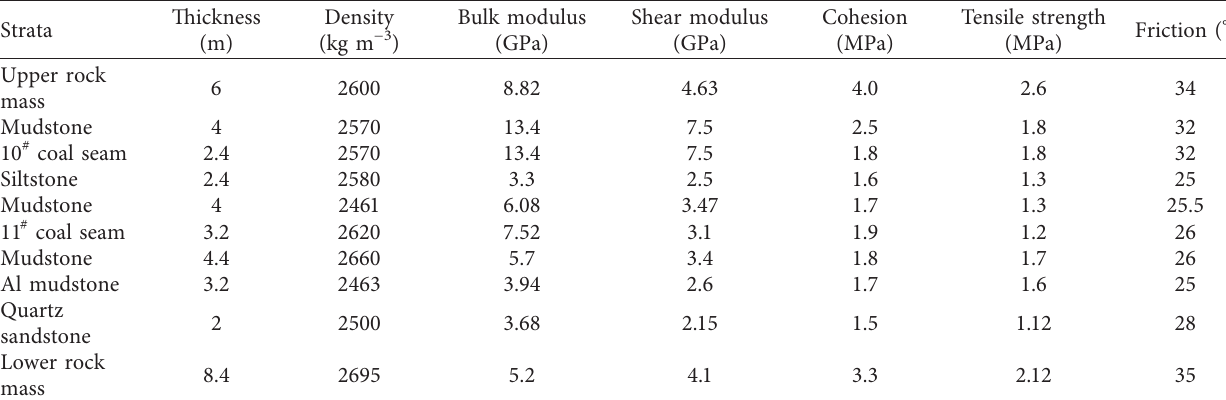
Figure 3: Distribution of the boundary line of the surrounding rock plastic zone. (a) σ v type stress field. (b) σ H type stress field. (c) σ h type stress field. Table 1: Rock physical and mechanical parameters